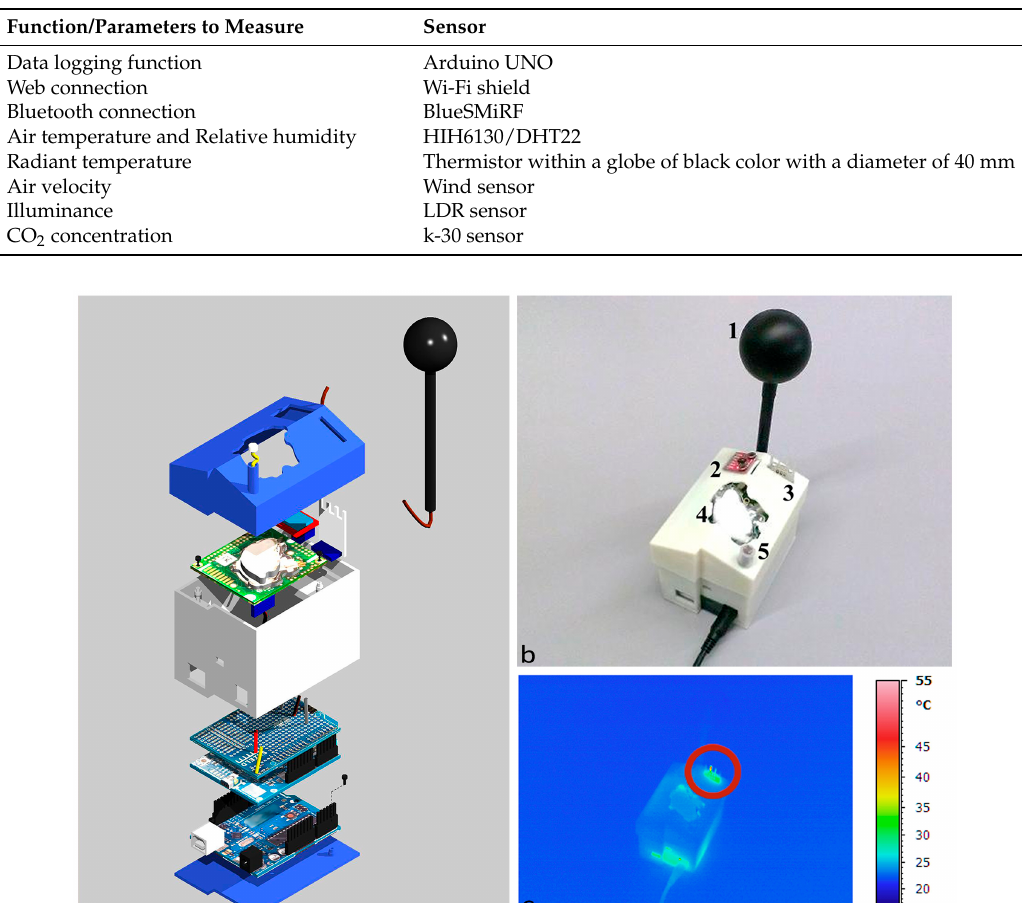
Table 1. Hardware of nEMoS device.